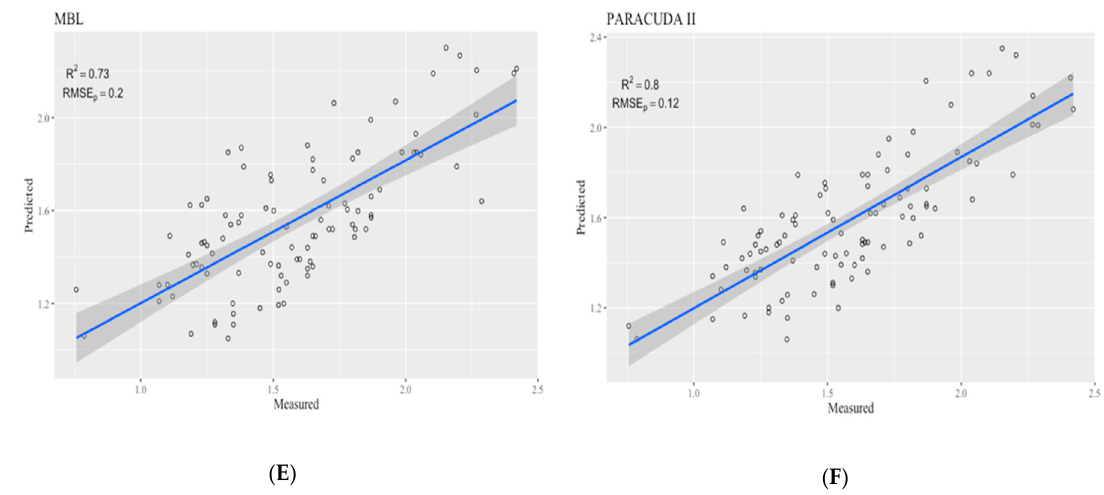
Figure 6. Scatterplots of predicted versus measured Cox using ( A ) PLSR, ( B ) RF, ( C ) BRT, ( D ) SVMR, ( E ) MBL, and ( F ) PARACUDA ‐ II ® techniques on validation dataset.